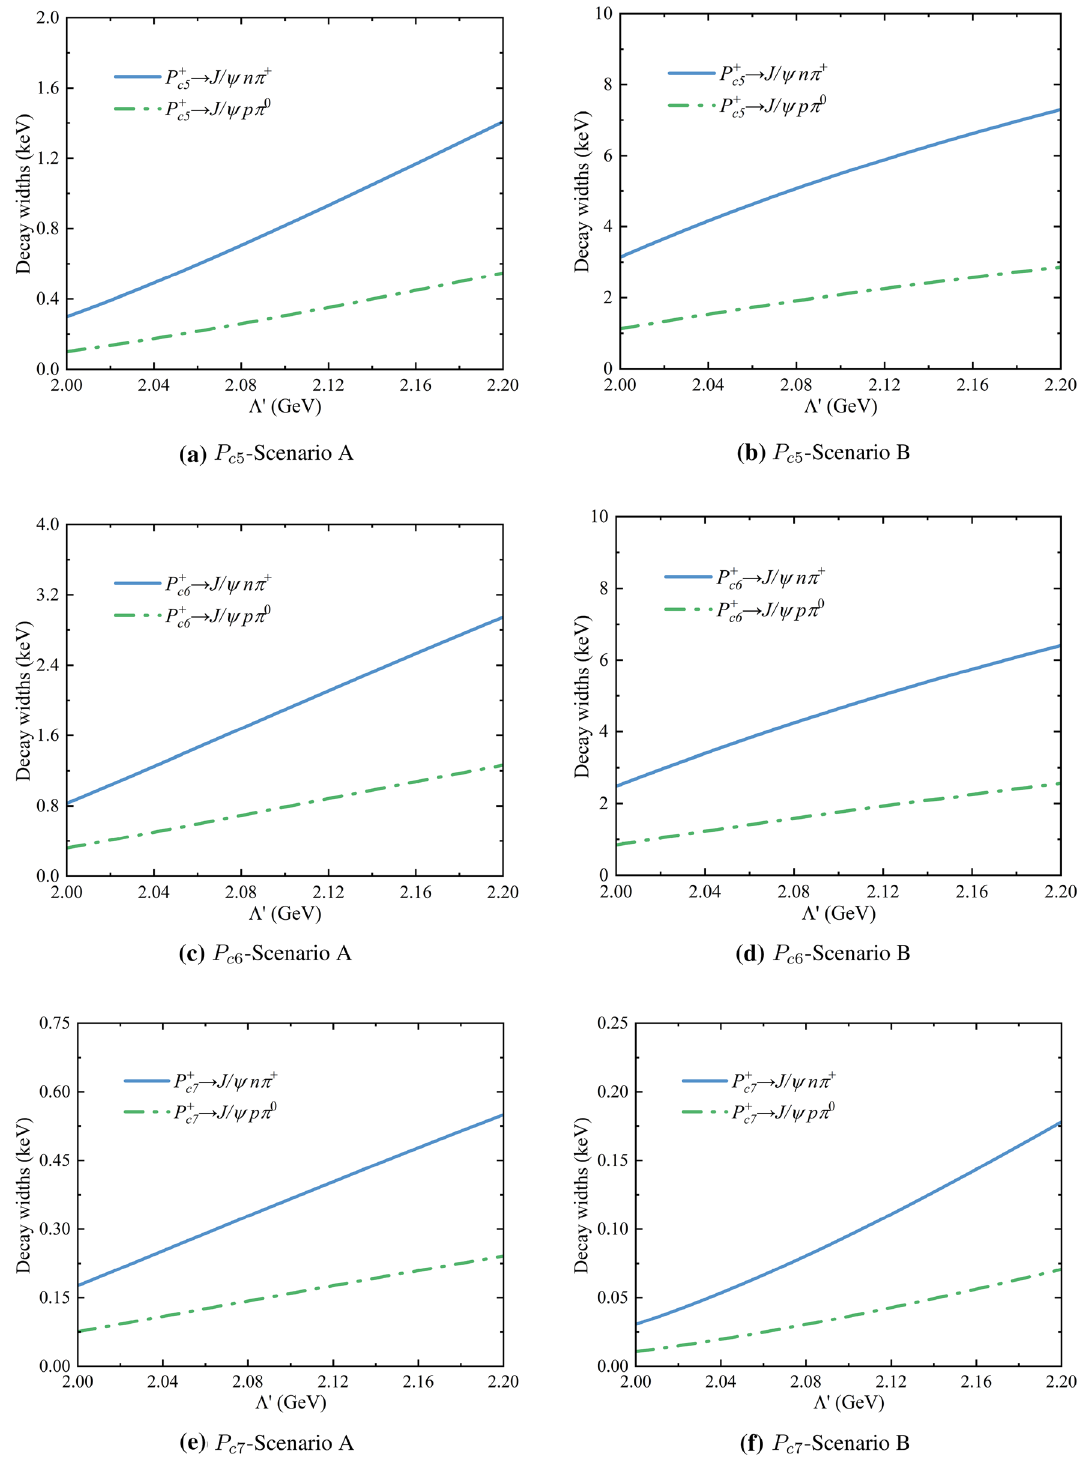
→ J /ψ n π + and P + → J /ψ p π 0 as a function of the cutoff (cid:4) (cid:9) of the form factor (A15). The results Fig. 5 Partial decay widths of P + c 5 | c 6 | c 7 c 5 | c 6 | c 7 are represented by the blue solid lines and green dot-dashed lines, respectively, which correspond to the couplings determined for a cutoff (cid:4) =